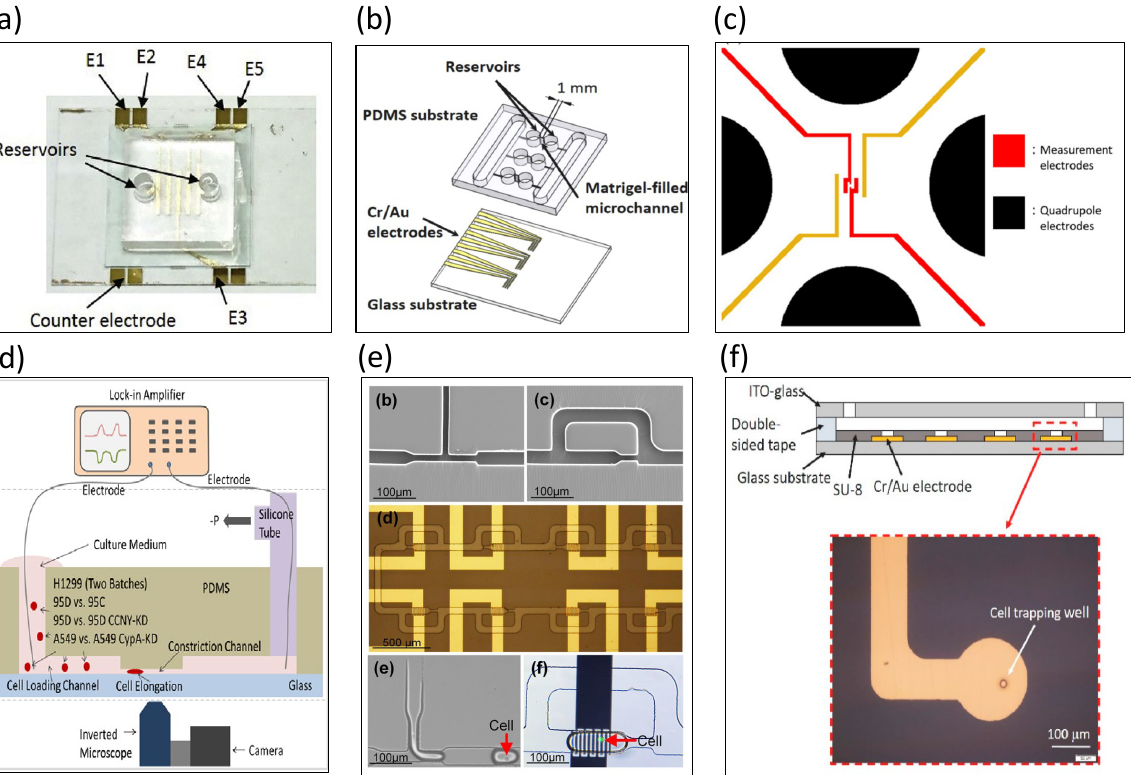
Figure 6. Static cell analyzed with electrical impedance spectroscopy. ( a ) A microchannel was designed filled with Matrigel to quantify cell migration velocity. Reproduced with permission from [72]. Copyright Analytica Chimica Acta 2020. ( b ) This chip was designed to induce angiogenesis to extend into the microchannel. Reproduced with permission from [73]. Copyright Sensors and Actuators B: Chemical 2022. ( c ) The relationship between the electrochemical impedance spectroscopy and withstand voltage was established with four different cells (HeLa, A549, MCF-7, and MDA-MB-231). Reproduced with permission from [74]. Copyright Sensors and Actuators B: Chemical 2012. ( d ) Because of the constriction of the microchannel, tumor cells, thus, are elongated for sensing impedance. Reproduced with permission from [75]. Copyright Biosensors and Bioelectronics 2014. ( e ) A microfluidic impedance sensing chip with droplets and microelectrode arrays was used to monitor the osteogenic differentiation of bone marrow mesenchymal stem cells. Reproduced with permission from [76]. Copyright Biosensors and Bioelectronics 2019. ( f ) Single stem cells